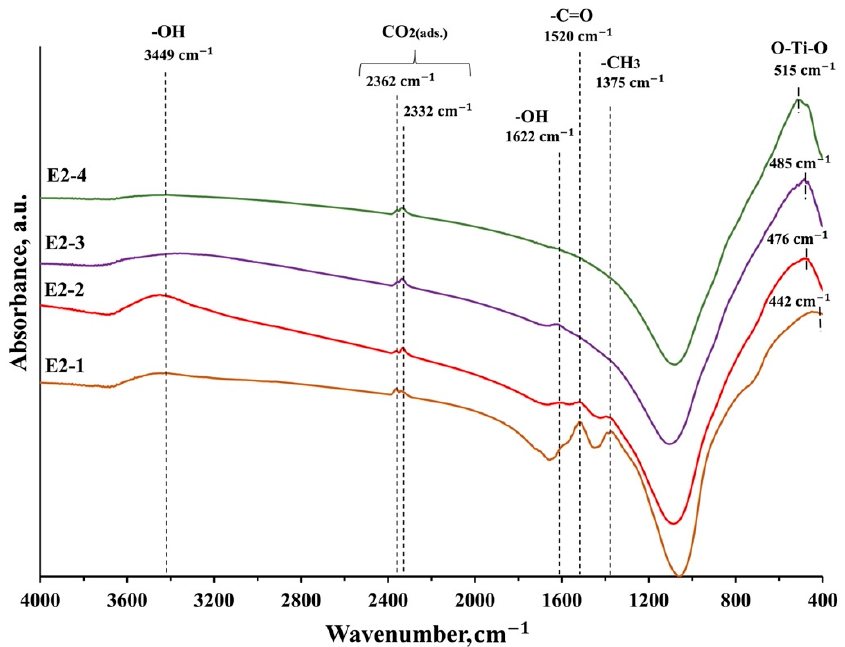
Figure 6. FTIR spectra of the samples produced from the precursor E2 at different pyrolysis temperatures: E2-1—350 ◦ C, E2-2—400 ◦ C, E2-3—450 ◦ C, E2-4—550 ◦ C.